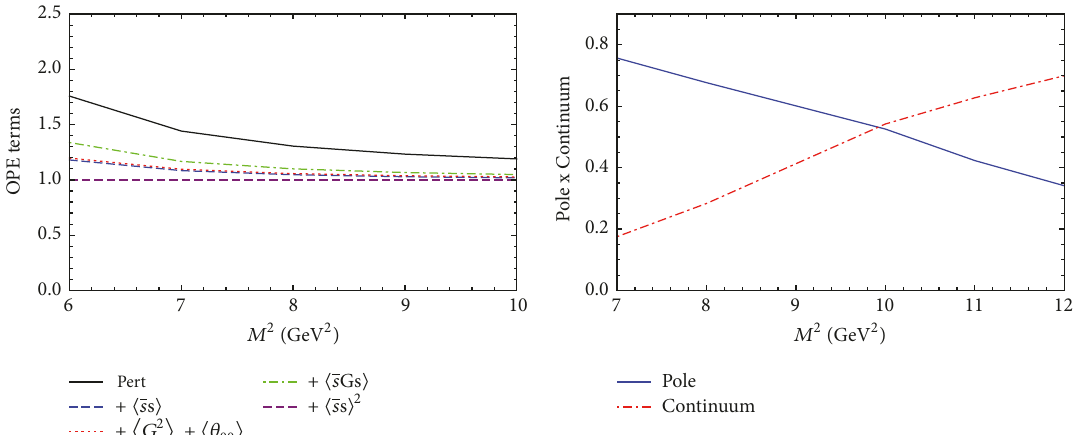
Figure 1: The OPE convergence of the sum rules: the ratio of the sum of the contributions up to specified dimension to the total contribution is plotted with respect to 𝑀 2 at 𝑠 0 = 134 GeV 2 , 𝑇 = 0 (left). Pole dominance of the sum rules: relative contributions of the pole (blue) and continuum (red-dashed) versus to the Borel parameter 𝑀 2 at 𝑠 0 = 134 GeV 2 ,𝑇 = 0 (right).